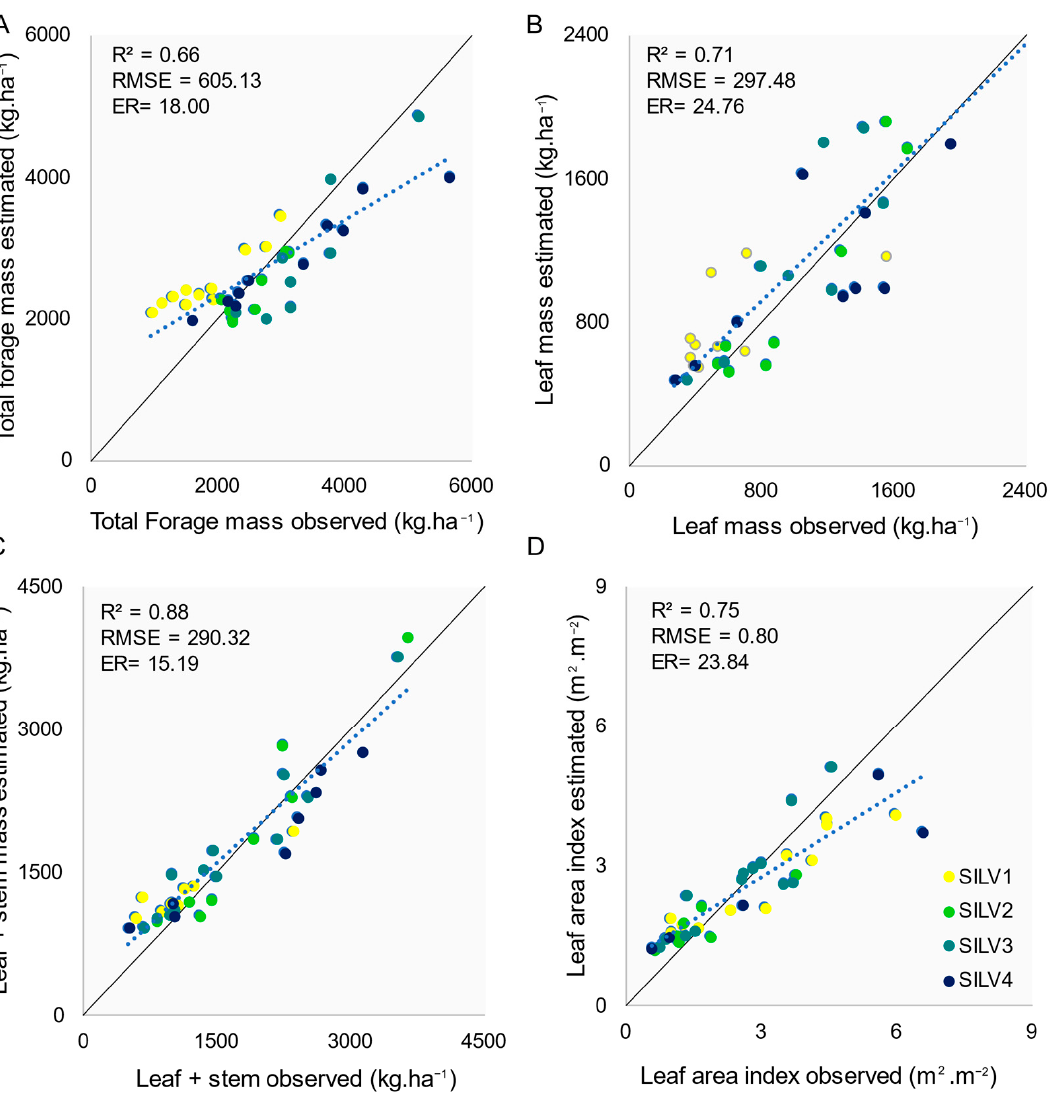
Figure 9. Observed and estimated variables linear regression of Piatã grass pasture in the SILV. ( A ) total dry mass (MSt); ( B ) dry mass of leaves (MSf); ( C ) leaf and stem dry mass (MSfc); ( D ) leaf area index (LAI).